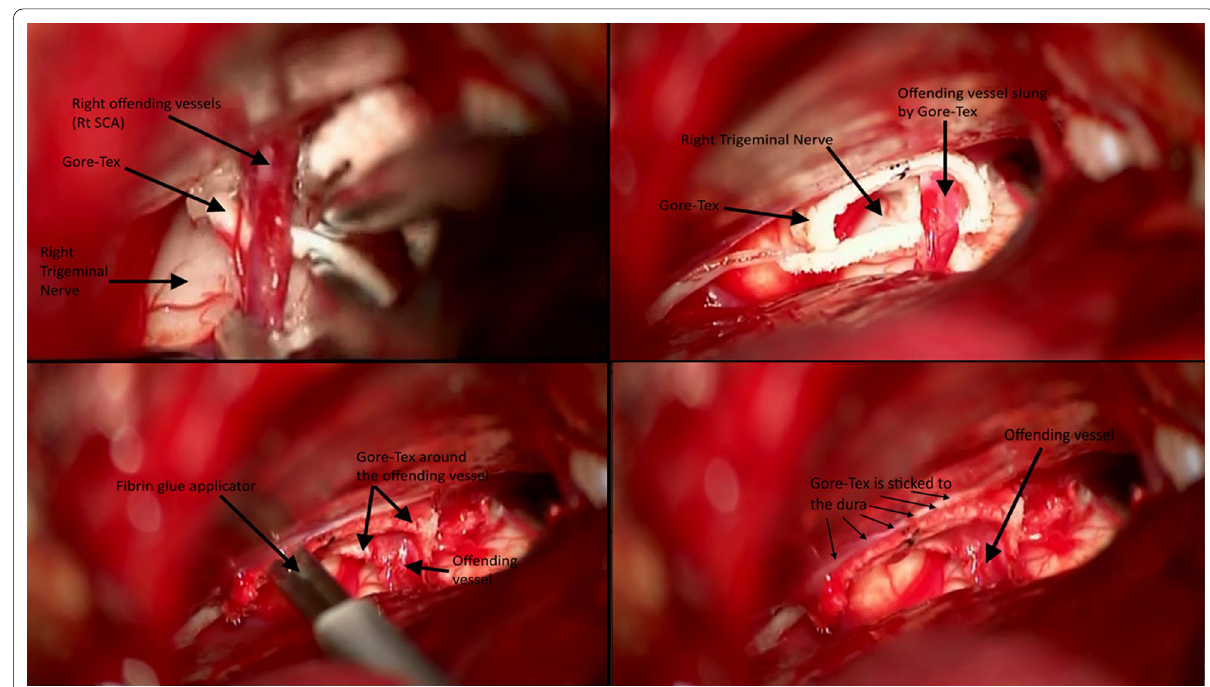
Fig. 2 Intraoperative pictures showing stages of MVD for treatment of right TN using the sling technique. The SCA is being slung with Gore-Tex away from the trigeminal nerve, fixed in situ using Fibrin Glue thus relieving the nerve